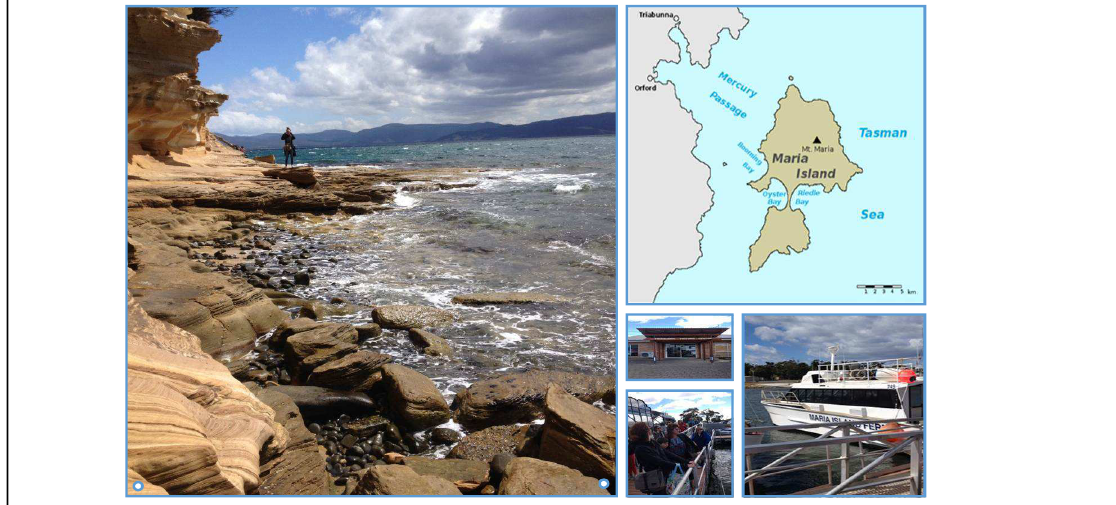
Figure A1.B1: Map of the study area and image from the passenger ferry and Maria